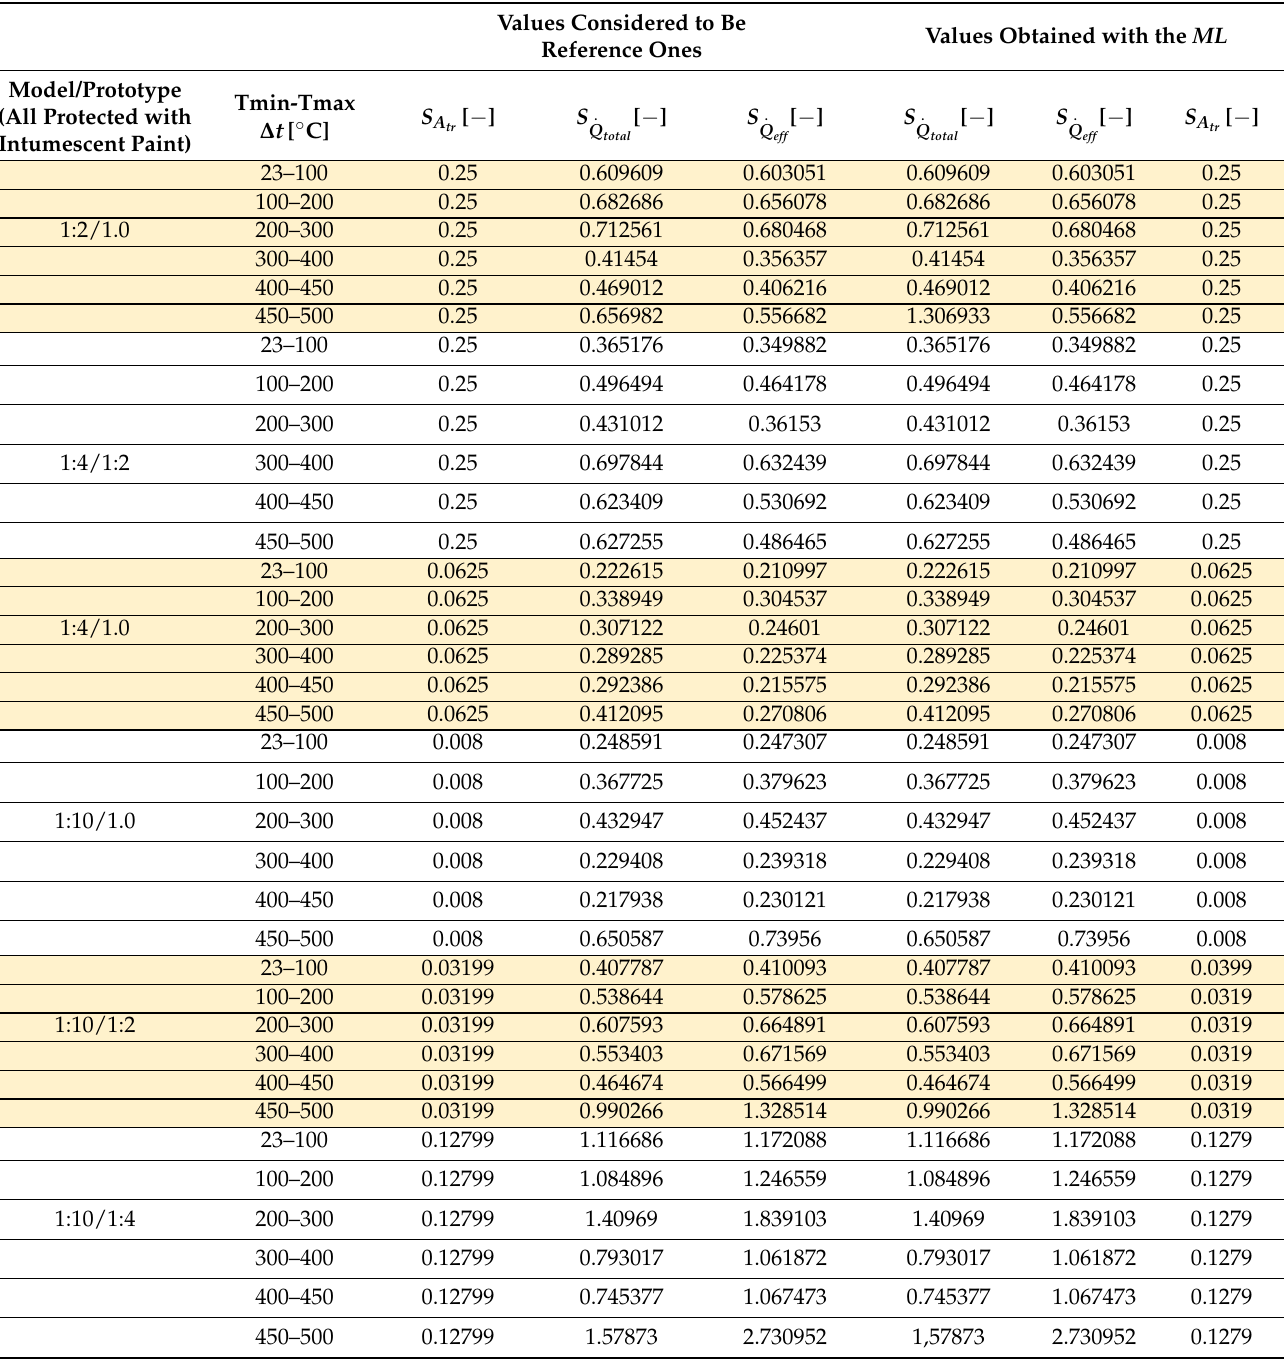
Table 5. Version I. The obtained values using